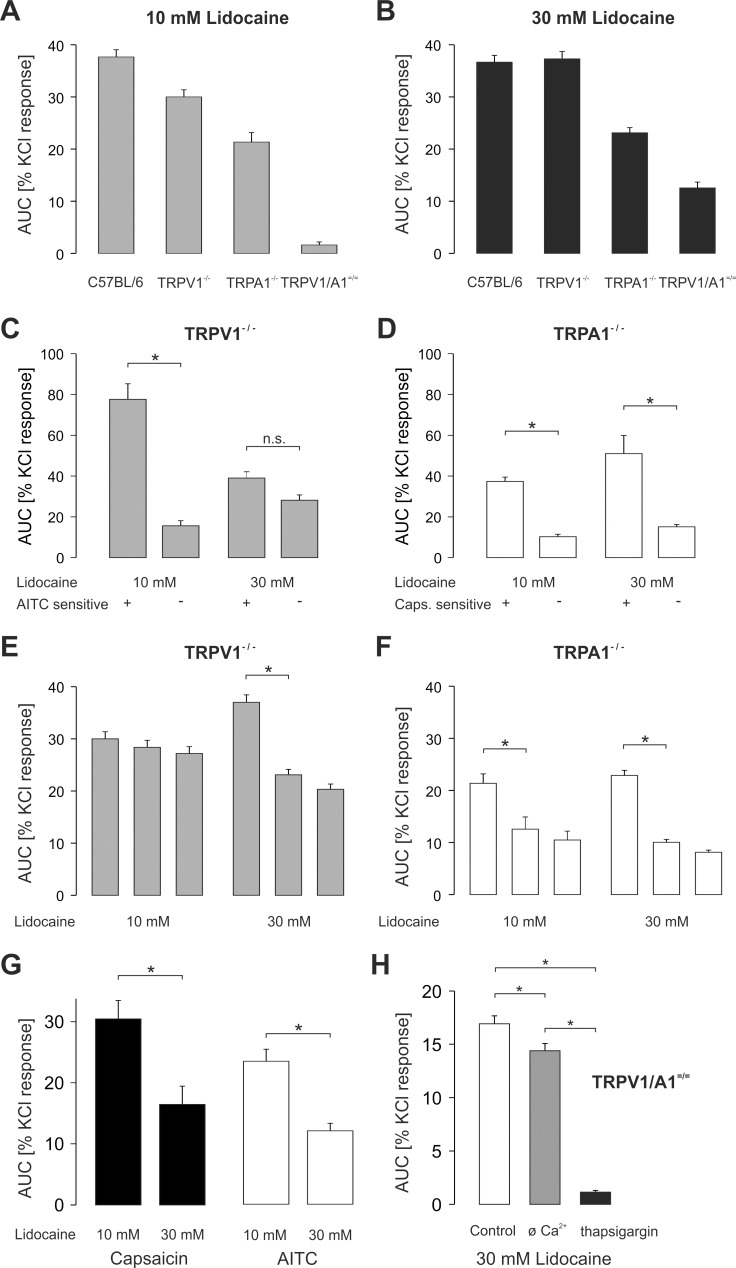
Areas under the curve (AUC) of increases in [Ca2+]i evoked by lidocaine.A-B. Areas under the curve of increases in intracellular calcium evoked by lidocaine 10 mM (A) and 30 mM (B) in DRG neurons of C57BL/6, TRPV1-/-, TRPA1-/- and TRPV1/A1-/- mice. Calcium responses to lidocaine stimuli significantly differ among the different genotypes (p ≤ 0.001), while at 30 mM lidocaine-evoked increase in [Ca2+]i is similar in neurons of C57BL/6 and TRPV1-/- mice (p = 1.0). C-D. Calcium responses to 10 and 30 mM lidocaine compared between AITC-positive and AITC-negative DRG neurons from TRPV1-/- mice (C) or between capsaicin-positive and capsaicin-negative DRG neurons from TRPA1-/- mice (D). * indicates p≤ 0.016 each. E-F. Calcium responses to three subsequent lidocaine stimuli show prominent desensitization, which involves TRPA1 receptors at 30 mM lidocaine (E; p = 0.00002) and TRPV1 receptors at 10 and 30 mM (F; p = 0.0002 and p = 0.00002). G. Increases in intracellular calcium evoked by capsaicin (0.3μM, black) or AITC (100μM, white bars) desensitize to a larger extent following 30 mM than after 10 mM lidocaine (p≤ 0.003; each). H. Lidocaine evokes calcium responses even in DRG neurons of TRPV1/A1-/- mice, which were reduced in calcium free extracellular solution (p = 0.004), but nearly abolished only by depletion of intracellular calcium stores by pretreatment with thapsigargin (2 μM, p = 0.00002). Data are normalized to a final 60 mM potassium stimulus applied to the neuros to evoke maximal calcium influx. Error bars represent S.E.M. (all ANOVA followed by HSD post hoc tests calculated for each panel separately apart from data presented in 2A+B).